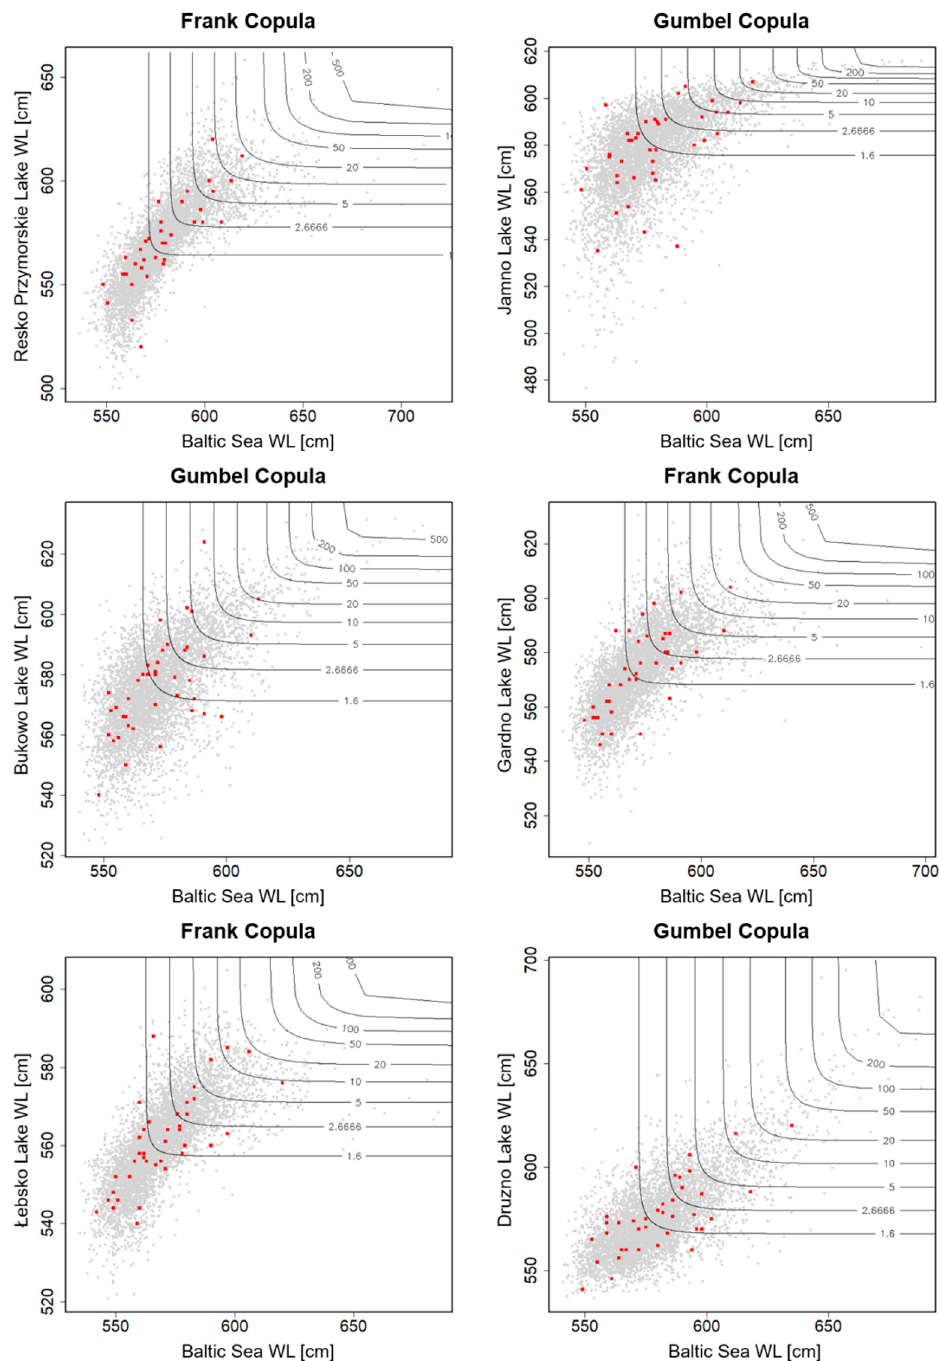
Figure 5. Total accumulated curves of probability of exceedance of maximum annual water levels for the correlation between water levels in the lakes and water level in the Baltic Sea. Red points are empirical pairs of values of maximum annual water levels. Gray points are generated theoretical points based on calculated parameters of joint distribution.